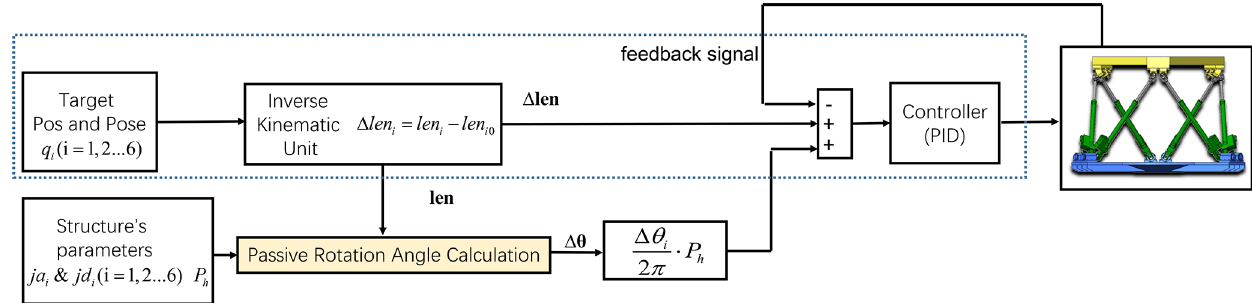
Figure 4. Compensation control strategy for PR.